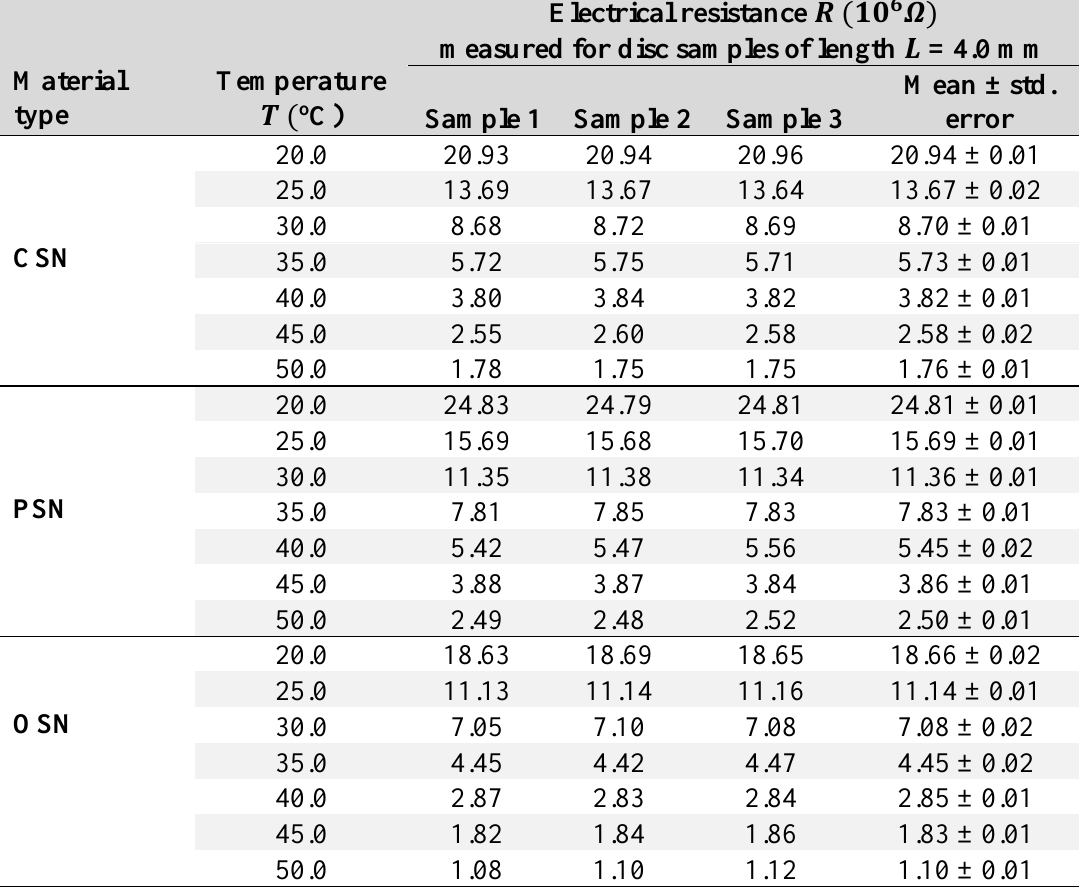
Table 4. Electrical resistance vs Temperature